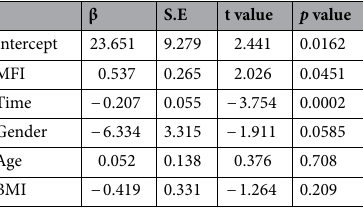
Table 3. The relationship between fatty infiltrates in the neck (MFI) and persistent neck pain disability in motor vehicle collision survivors examined as part of this study.